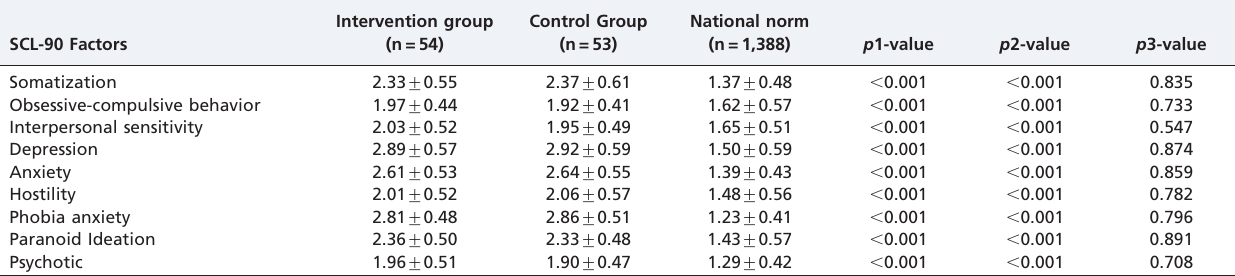
Table 2 - Between-group comparisons of SCL-90 psychological symptoms and the national norm (mean ¡ SD). Intervention group SCL-90 Factors (n=54)